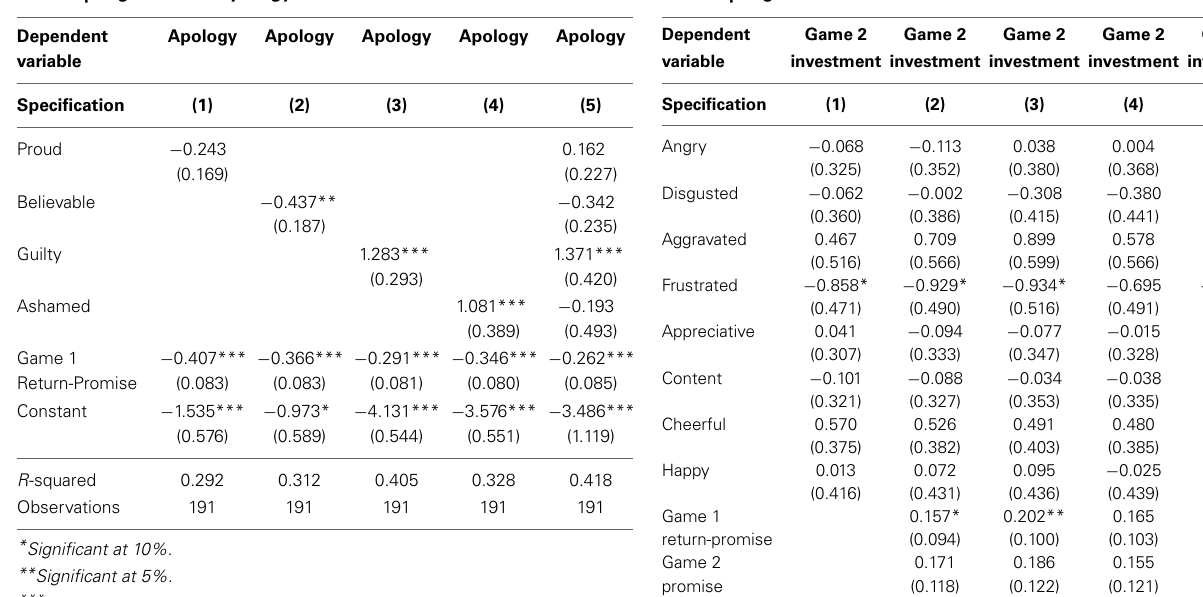
Table 7 | Regression of apology on trustees’ emotions. Table 8 | Regression of trust re-extension on investors’